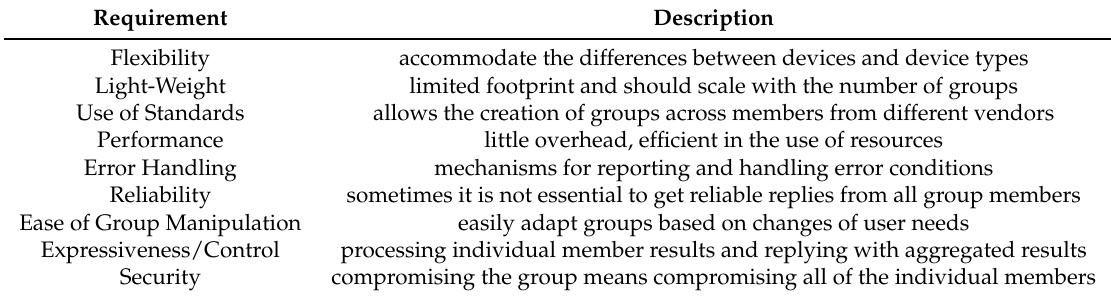
Table 2. Group communication requirements.